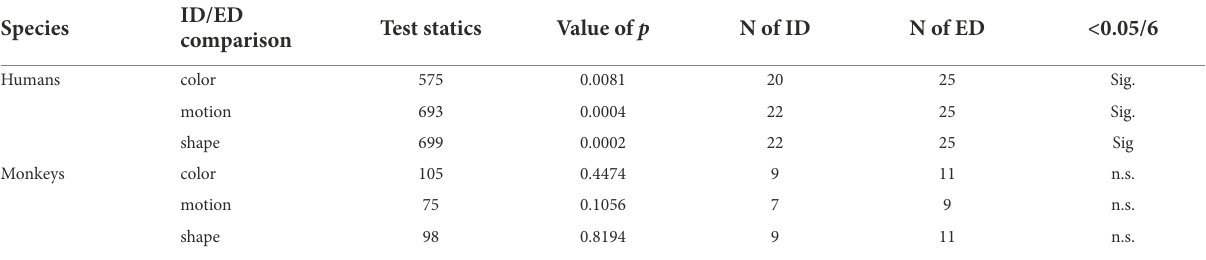
TABLE 2 Overview of the results from the Wilcoxon rank sum, non-paired, two-sided test on CFI differences between intra-dimensional and extra- dimensional shifts, separately for rule types (color, motion, shape) and humans and monkeys separately (Figures 5C,D). ID/ED Species Test comparison